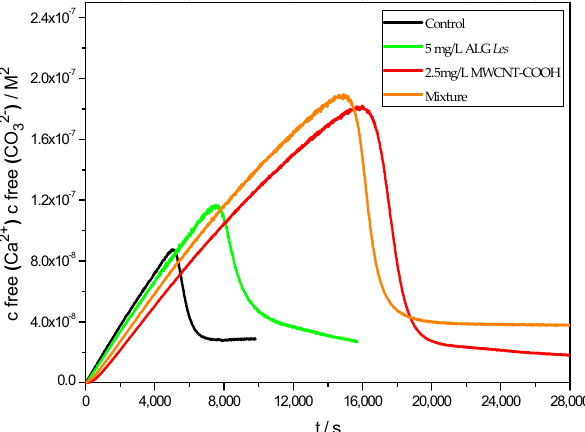
Figure 9. Time development of CaCO 3 solubility products using ALG Les and MWCNT-OH at pH 9.0: blank ( black line ), 5 mg/L ALG Les ( green line ), 2.5 mg/L MWCNT-COOH ( red line ), and both in mixture ( orange line ).